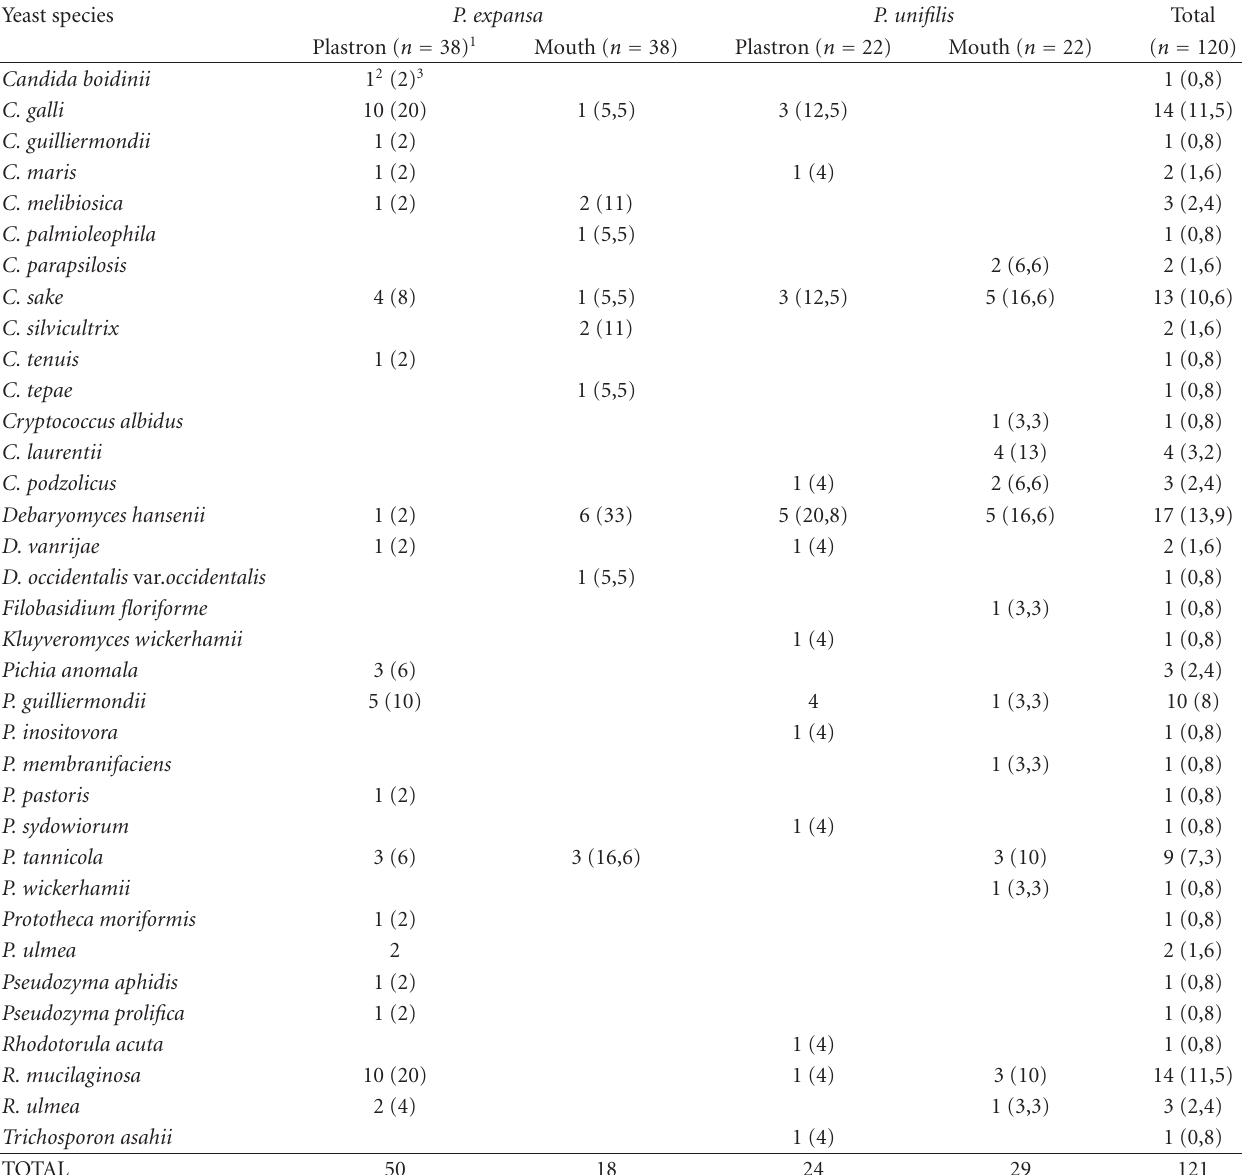
Table 1: Occurrence and frequencies of yeast species in surfaces (plastron) and mouth of Podocnemis expansa and P. unifilis. Yeast